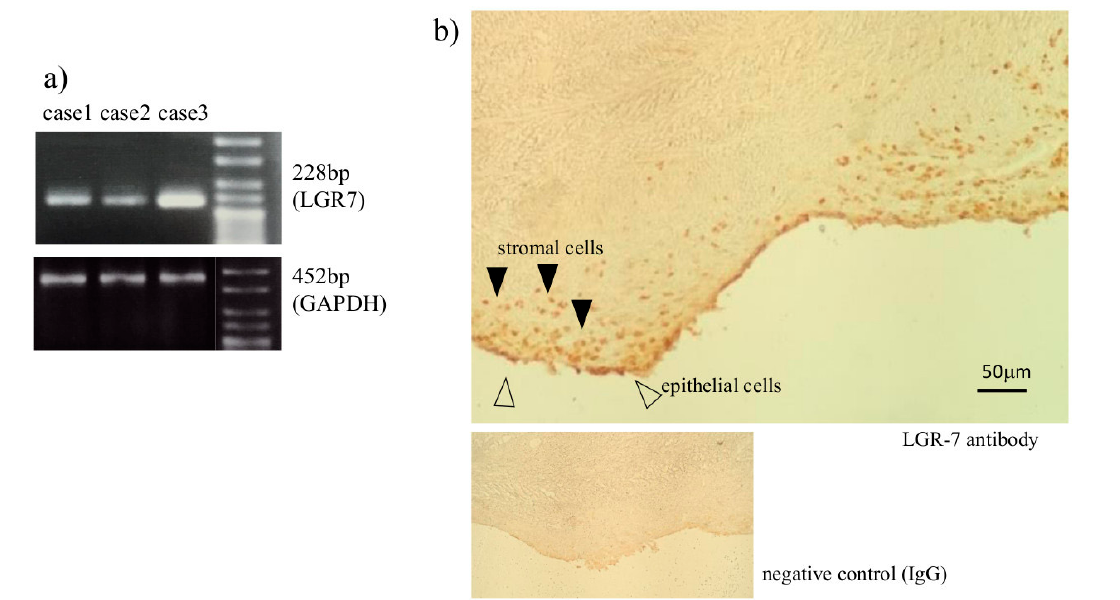
Figure 1. The expression of LGR-7 in the endometriotic lesion. Endometriotic stromal cells (ESCs) were obtained from three endometriomas and analyzed by conventional PCR for the mRNA expression of LGR-7, a receptor of relaxin (RLX)-2, and GAPDH ( a ). The expression of LGR-7 protein detected by immunohistochemistry in endometriomas is shown. Arrowheads indicated the expression of LGR-7 in stromal cells ( (cid:78) ) and epithelial cells ( (cid:52) ). Rabbit IgG was used as a negative control ( b